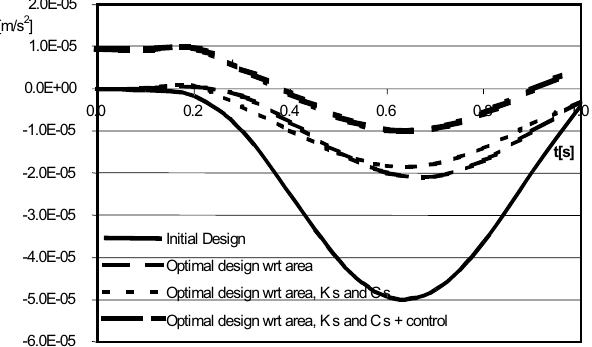
Fig. 9. Vehicle suspension max. acceleration [m/s 2